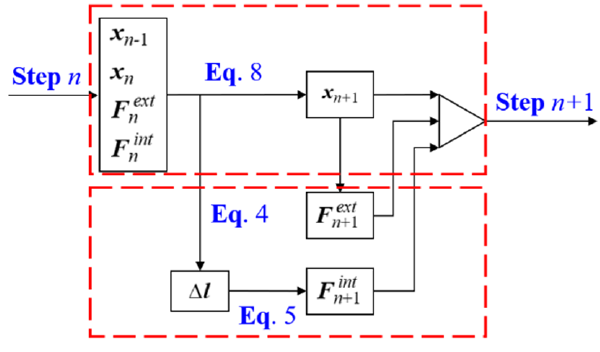
Figure 5. Calculation flow of VFIFE.